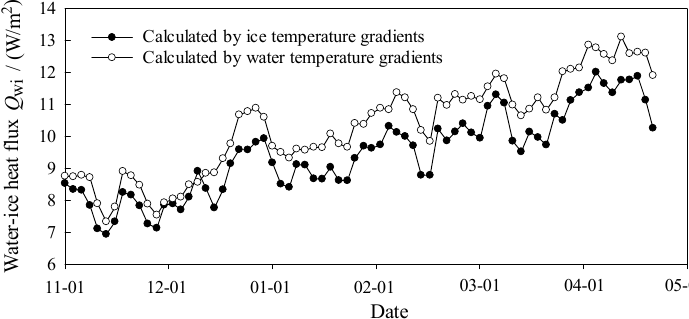
Figure 9. Seasonal variations in water–ice heat flux over the ice-cover duration. Overall, the average relative difference of heat flux calculated by using the temperature gradients on two sides of either interface is less than 7.9%. As it happens, the temperature observation operation was not very strictly controllable due to the limitation of natural conditions, and the average relative difference within 7.9% can be regarded as an insignificant statistical difference for the prototype observation. Therefore, the natural convection heat transfer process in water cannot be arbitrarily judged by the difference between the results of the two calculation methods. For the sediment–water heat flux, the average relative difference between the values calculated using the water side and either side is 7.9%, larger than that of water–ice heat flux, which might be due to the uncertainty of some of the parameters in the calculation of sediment thermal conductivity.